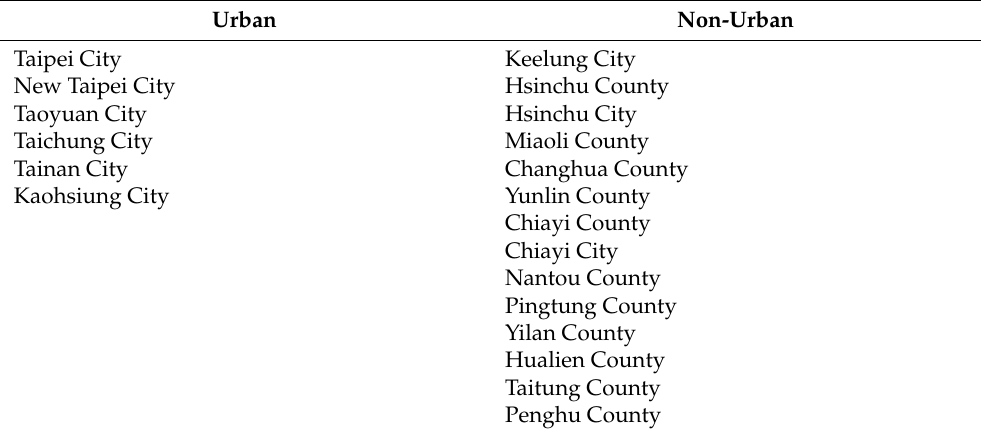
Table 6. Urban and non-urban cities and